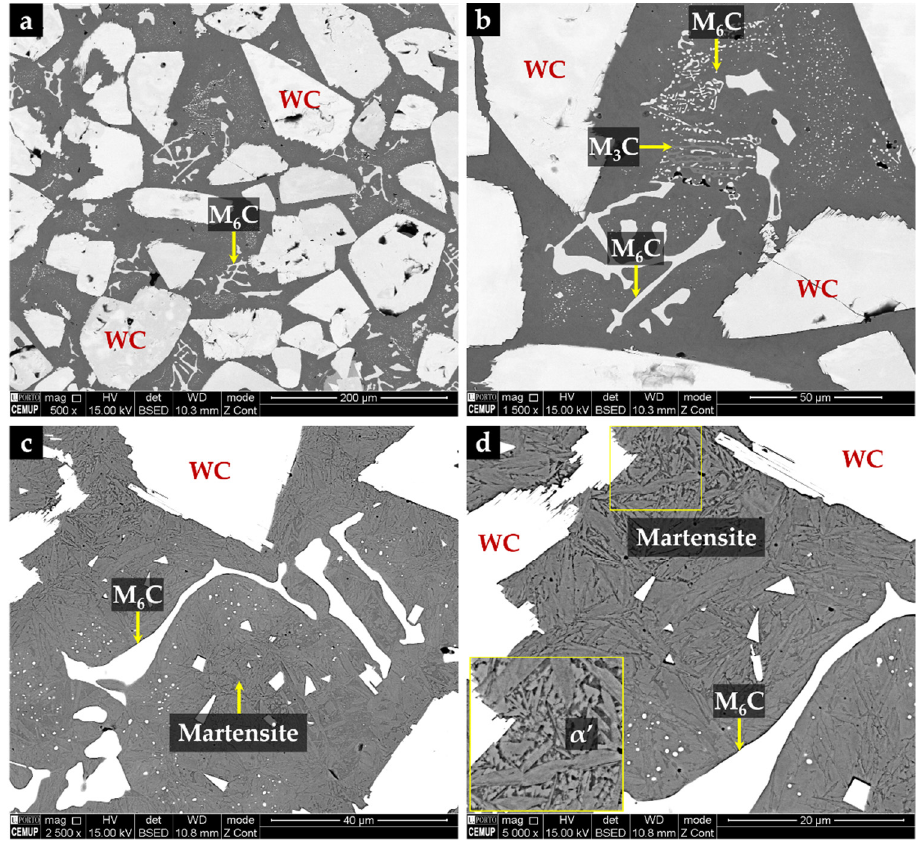
Figure 16. SEM-BSE images of the microstructure of the CZ1 composite zone: ( a ) uniform distribution of large polygonal-shaped WC particles and small particles of (Fe,W,Cr) 6 C, ( b ) higher magnification of ( a ) showing fine precipitation of (Fe,W,Cr) 3 C and (Fe,W,Cr) 6 C, ( c ) α ’ matrix revealed with 10% oxalic acid, and ( d ) higher magnification of ( c ) showing the α ’ plate-like morphology.